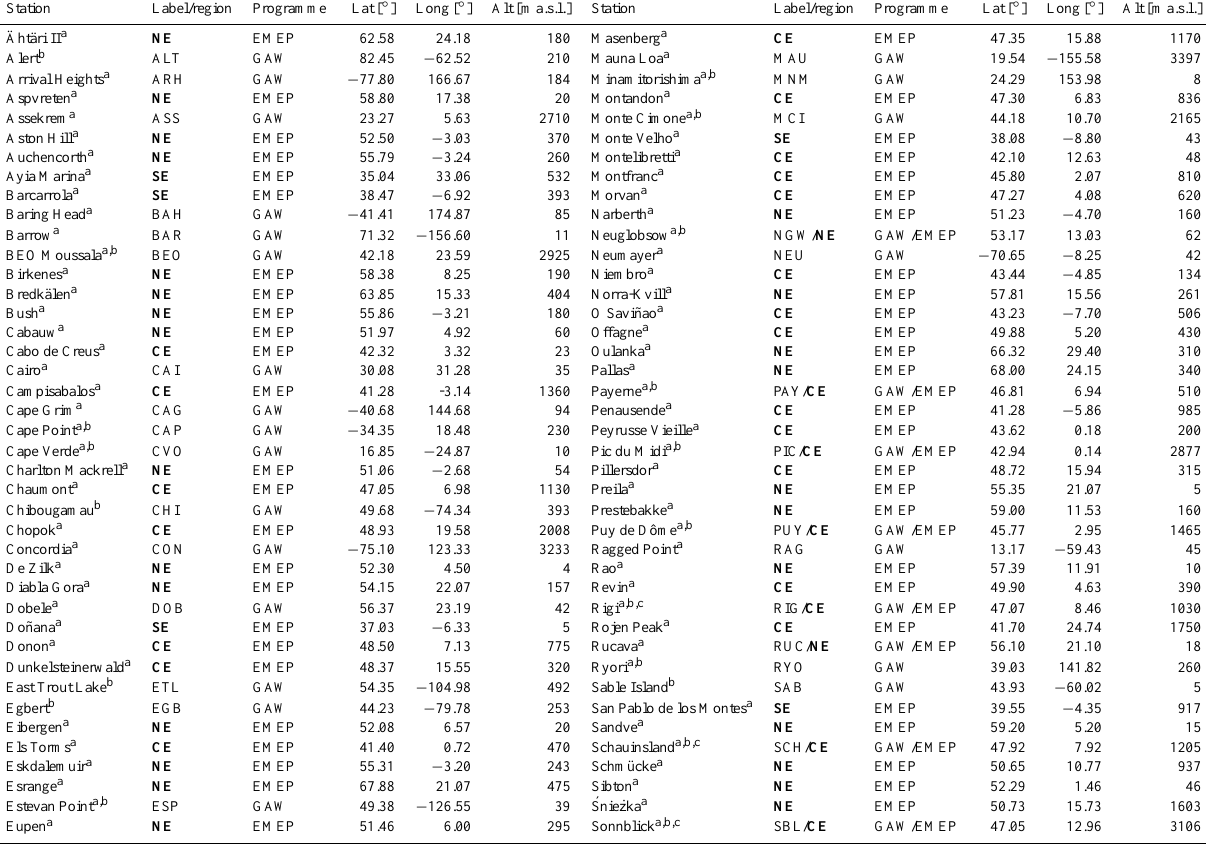
Table 3. List of GAW and EMEP stations used in the evaluation (GAW listed by label, EMEP listed by region: northern Europe NE; central Europe CE; and southern Europe, SE). The numbers by the station name provide the type of gas: a = O 3 , b = CO, c = NO 2 . Positive latitude values refer to the Northern Hemisphere, negative latitude values to the Southern